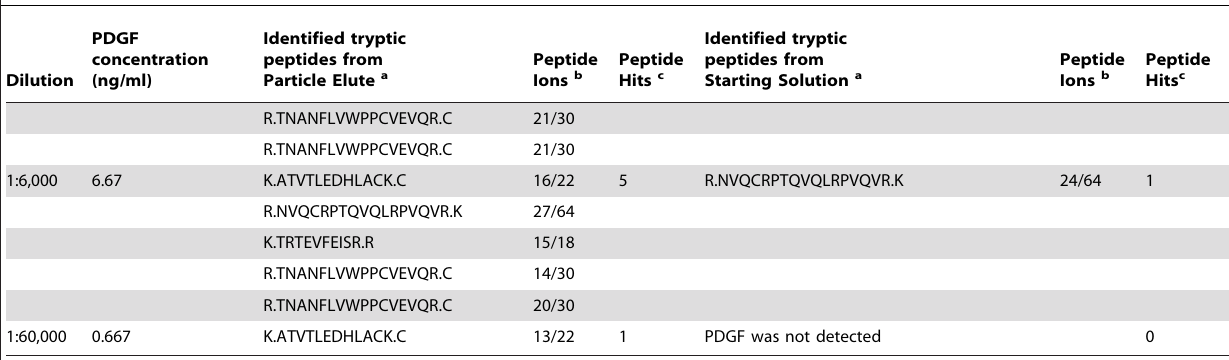
b Peptide Ions is the ratio of number of matched b-ions and y-ions to the number of theoretical b-ions and y-ions for the identified peptide based on Sequest database search result. c Peptide Hits is the total number of identified peptides (including the same peptide with the same charge, the same peptide with different charge, and the different peptide) from one protein based on Sequest database search